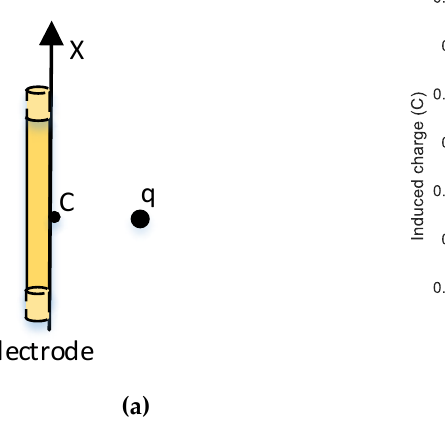
Figure 12. Effect of the electrode length change on the induced charge: ( a ) Increasing the length of the sensing electrode; and ( b ) variation of the amount of the induced charge with the electrode length.